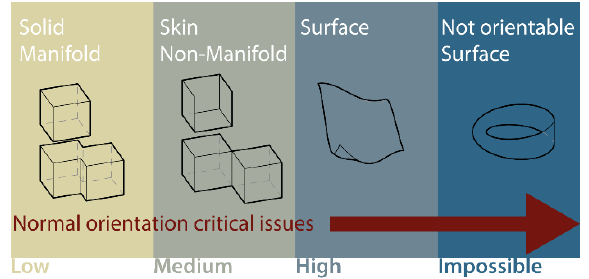
Figure 3: Normal orientation critical